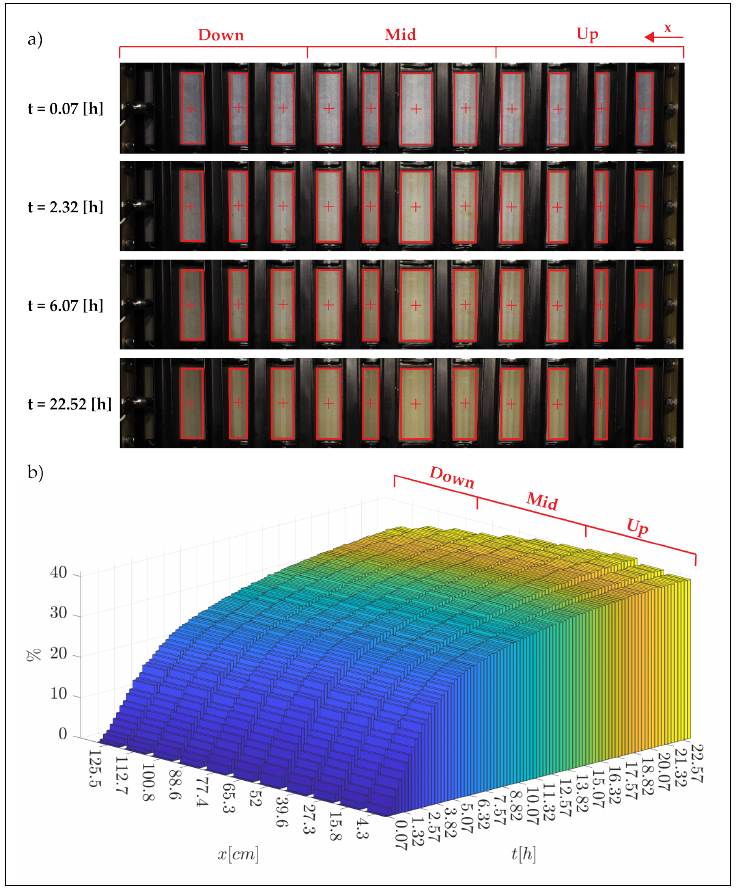
Figure 5. Data related to colloidal fouling of the membrane. ( a ) Photographs from the overhead cam- era taken over the entire span of the test section and at different times, t (test S-4_1.5); ( b ) percentage variation of the membrane color (yellow band) measured at different longitudinal positions along the membrane surface (i.e., in each of the red boxes highlighted in panel ( a ) as a function of time).